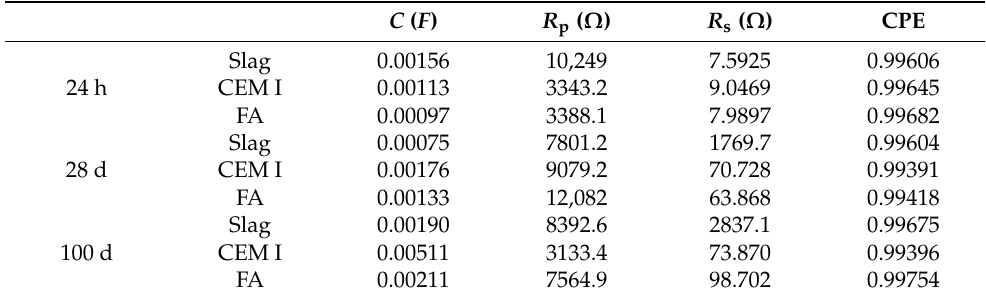
Table 6. Characteristic parameters obtained from de fitting of the Nyquist diagrams to a Randle equivalent circuit. Only one specimen per mortar type was tested.